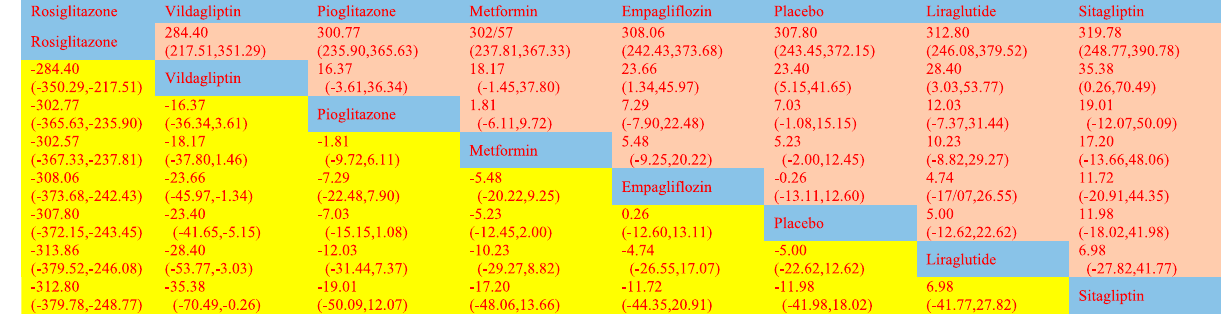
TABLE 2 League table on ALT.